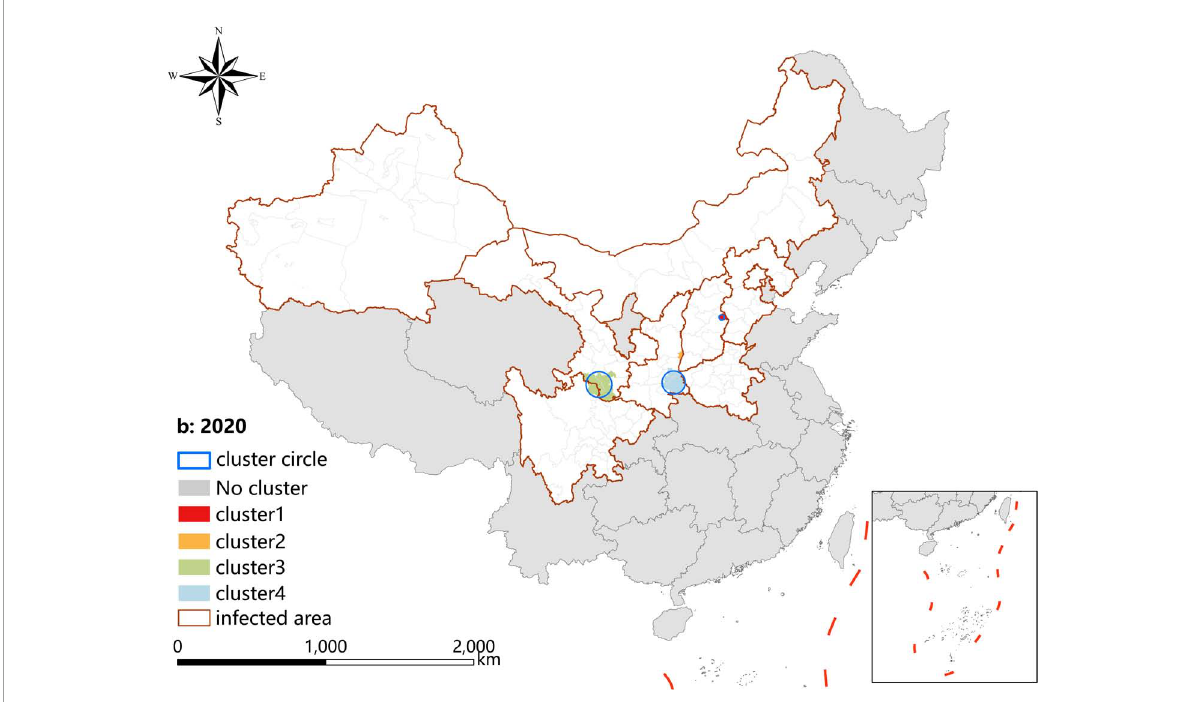
FIGURE7 Spatio-temporal clustering analysis of visceral leishmaniasis incidence in mainland China in 2020.